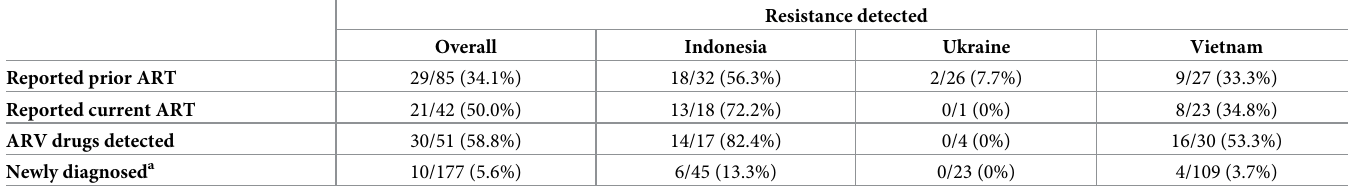
Table 2. Frequency of HIV drug resistance by antiretroviral drug